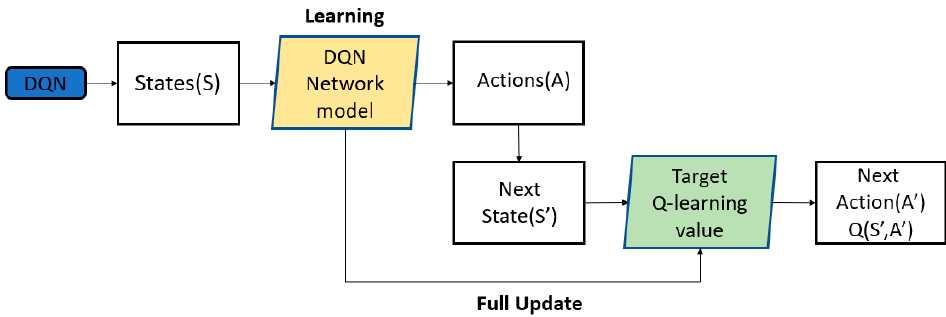
Figure 3. DQN network structure with targeted Q-learning outcomes in operation with